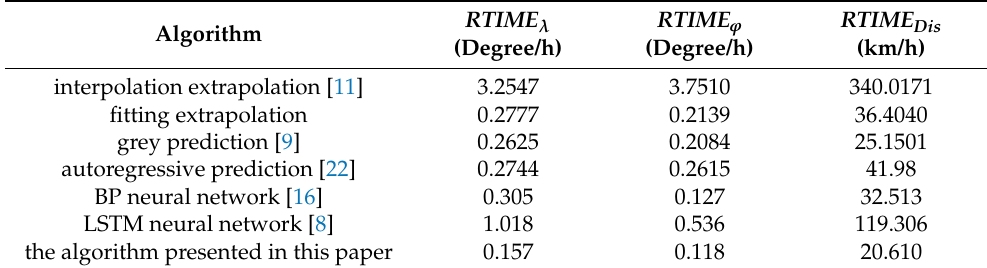
Figure 6. Visualization of trajectory predictions. The horizontal axis is longitude, and the vertical axis is latitude. In addition, the blue curve is the real trajectory, and the orange curve is the prediction trajectory. Table 3. Performance comparison with other